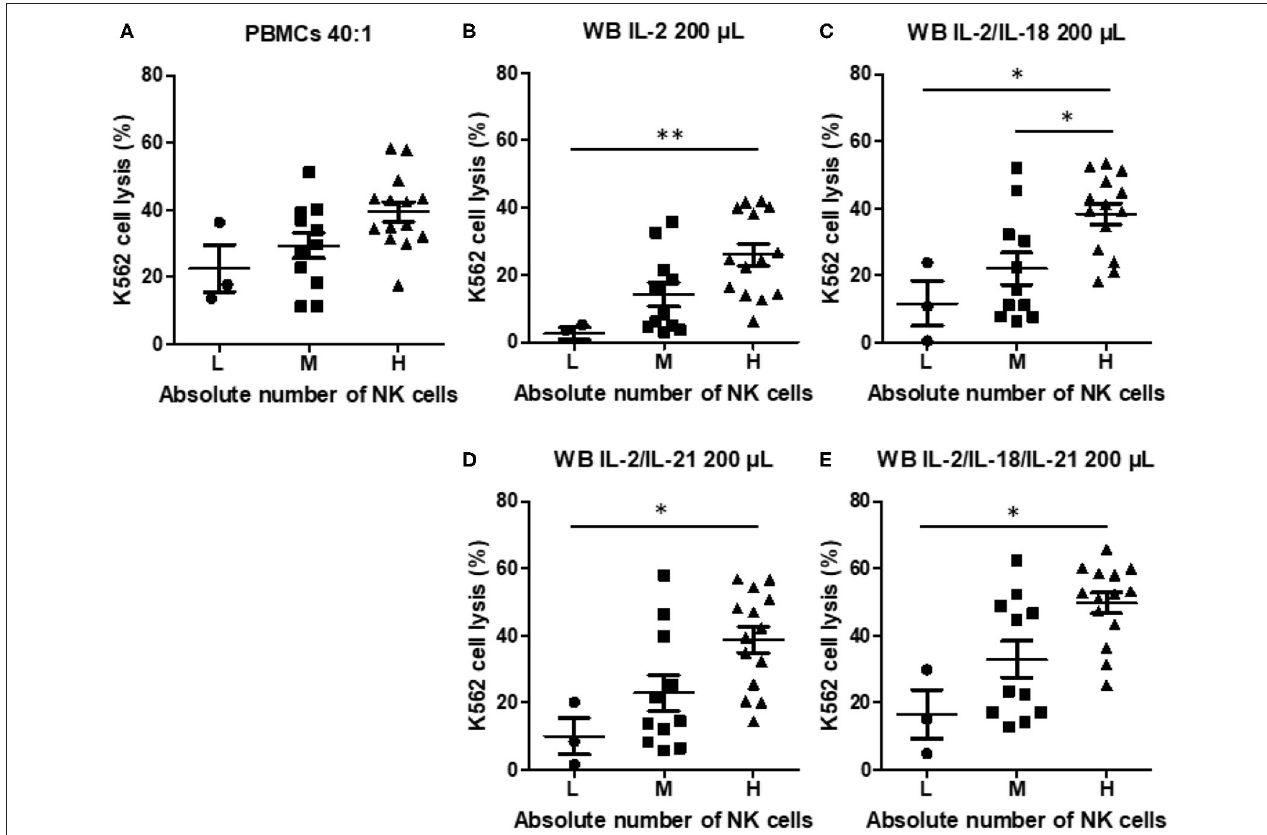
FIGURE 5 | Natural killer (NK) cytotoxicity measured by peripheral blood mononuclear cells (PBMC) NK cytotoxicity (40:1) and whole blood (WB)-based NK cytotoxicity (200 µ L) according to the absolute number of NK cells (low, three donors; medium, 11 donors; high, 14 donors). NK cytotoxicity results using (A) PBMCs and WB activated overnight with (B) IL-2, (C) IL-2/IL-18, (D) IL-2/IL-21, and (E) IL-2/IL-18/IL-21. Data are represented as the mean ± SEM (* p < 0.05; ** p <